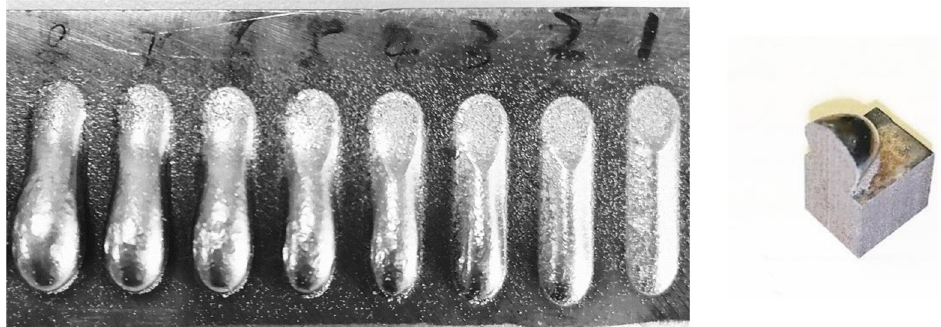
Figure 5. The printed specimens and the cut section for metallographic observations.